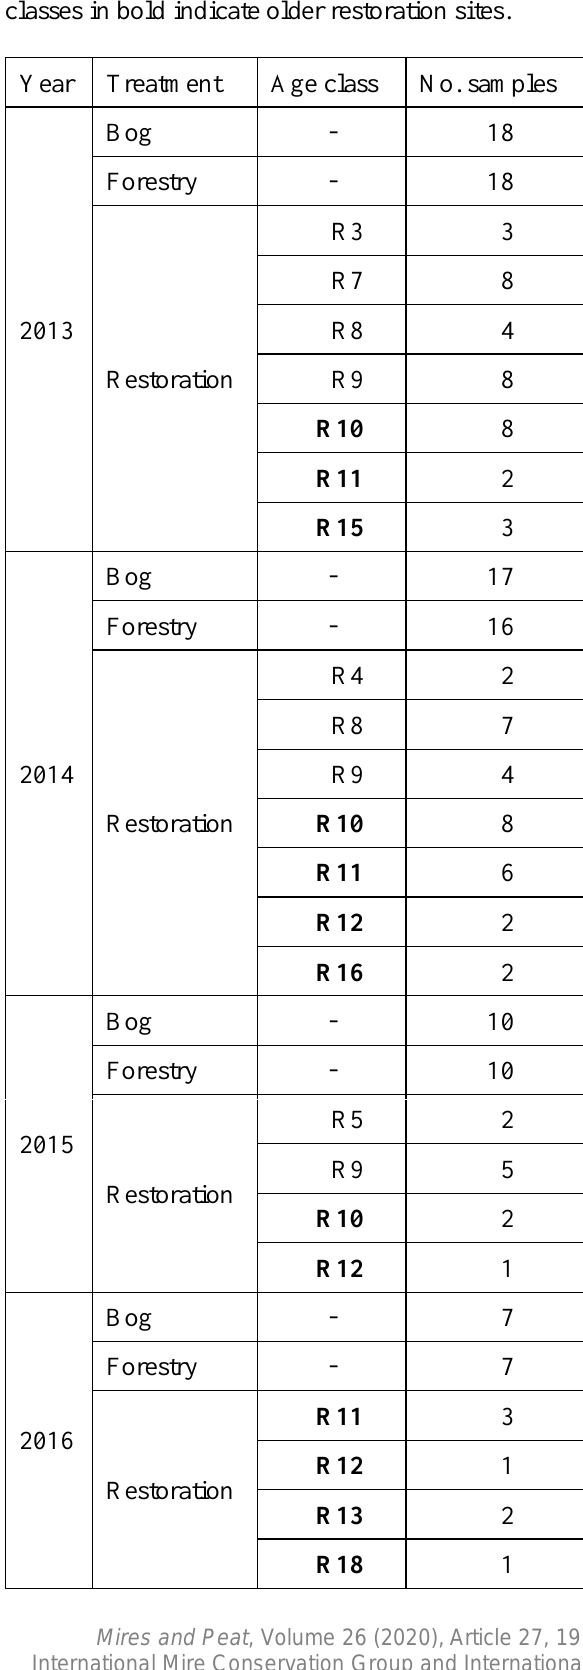
Table 1. Experimental design for moth trapping at Forsinard. Bog, forestry and restoration treatments were simultaneously sampled over four consecutive years between July and August 2013–2016. Age class represents time in years since restoration began. Age classes in bold indicate older restoration